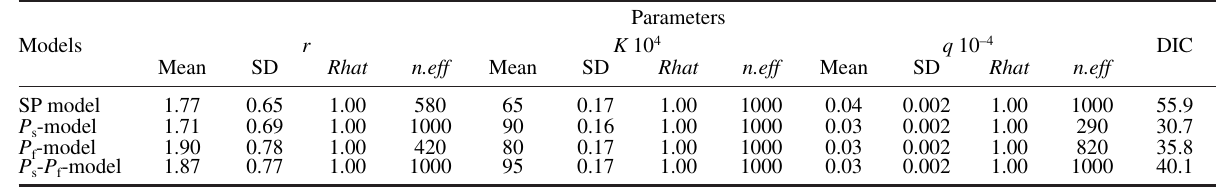
Table 2. – Summary statistics for the parameters of Schaefer surplus production models of O. bartramii .